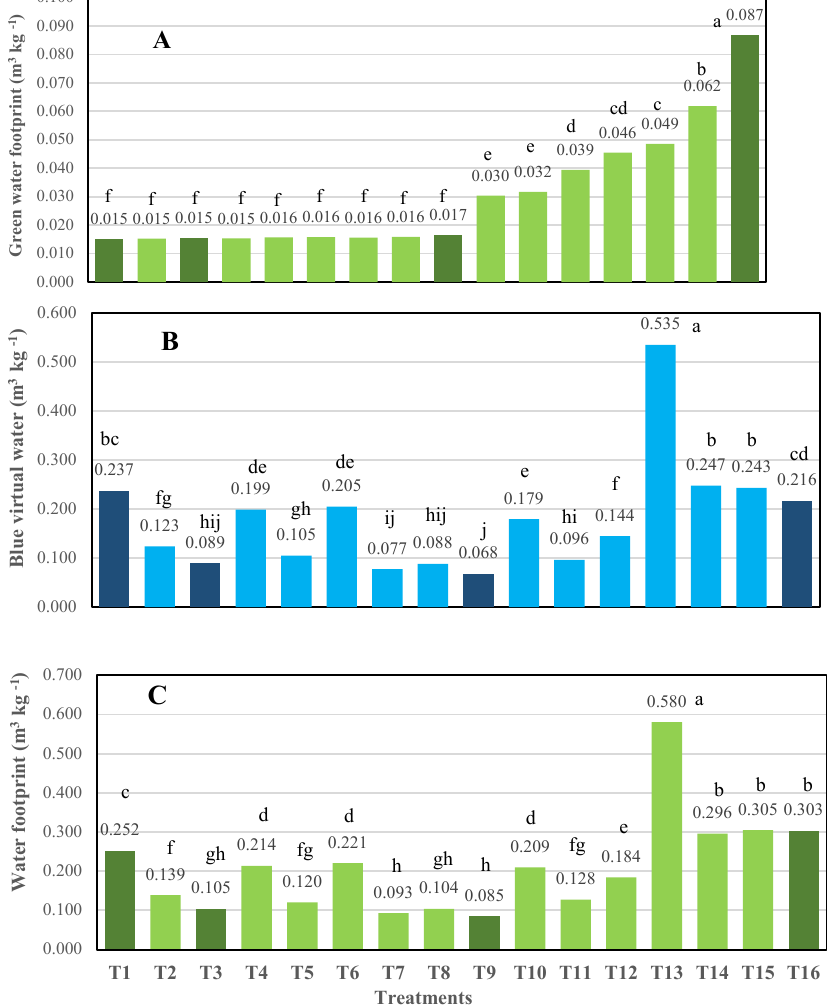
Figure 5. Green water footprint ( A ), blue water footprint ( B ), and water footprint ( C ). Dark green and blue bars correspond to treatments with the same soil moisture tension during the two phenological stages. Different letters on the bars mean statistical differences (Tukey, p ≤ 0.05). T1 to T16 are soil moisture tension treatments (kPa).